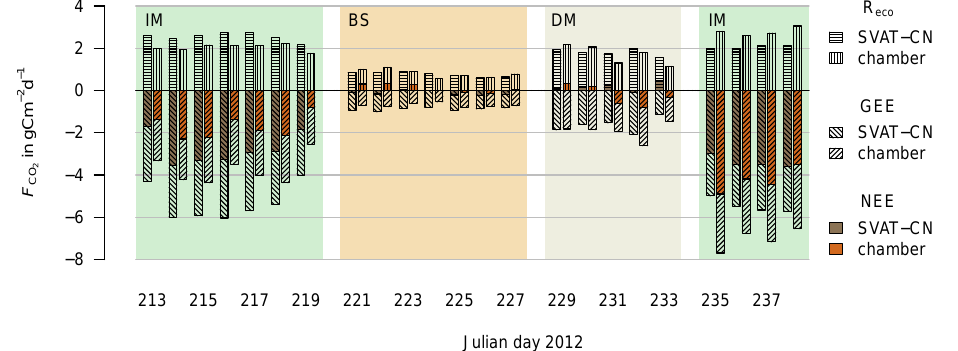
Figure 4. Comparison of measured and modelled daily carbon exchange sums from 31 July to 25 August 2012 at Kema. Hatched bars denote the simulated gross ecosystem exchange (GEE) and ecosystem respiration ( R eco ), the sum is the net ecosystem exchange (NEE, coloured bars). The four periods represent different stages of vegetation degradation (see Table 2). Leaf physiology and soil respiration was parameterised for best representation of the gas exchange chamber data over the entire time period (see Sect. 2.5.2). Missing dates indicate days when chambers were set up or relocated to another